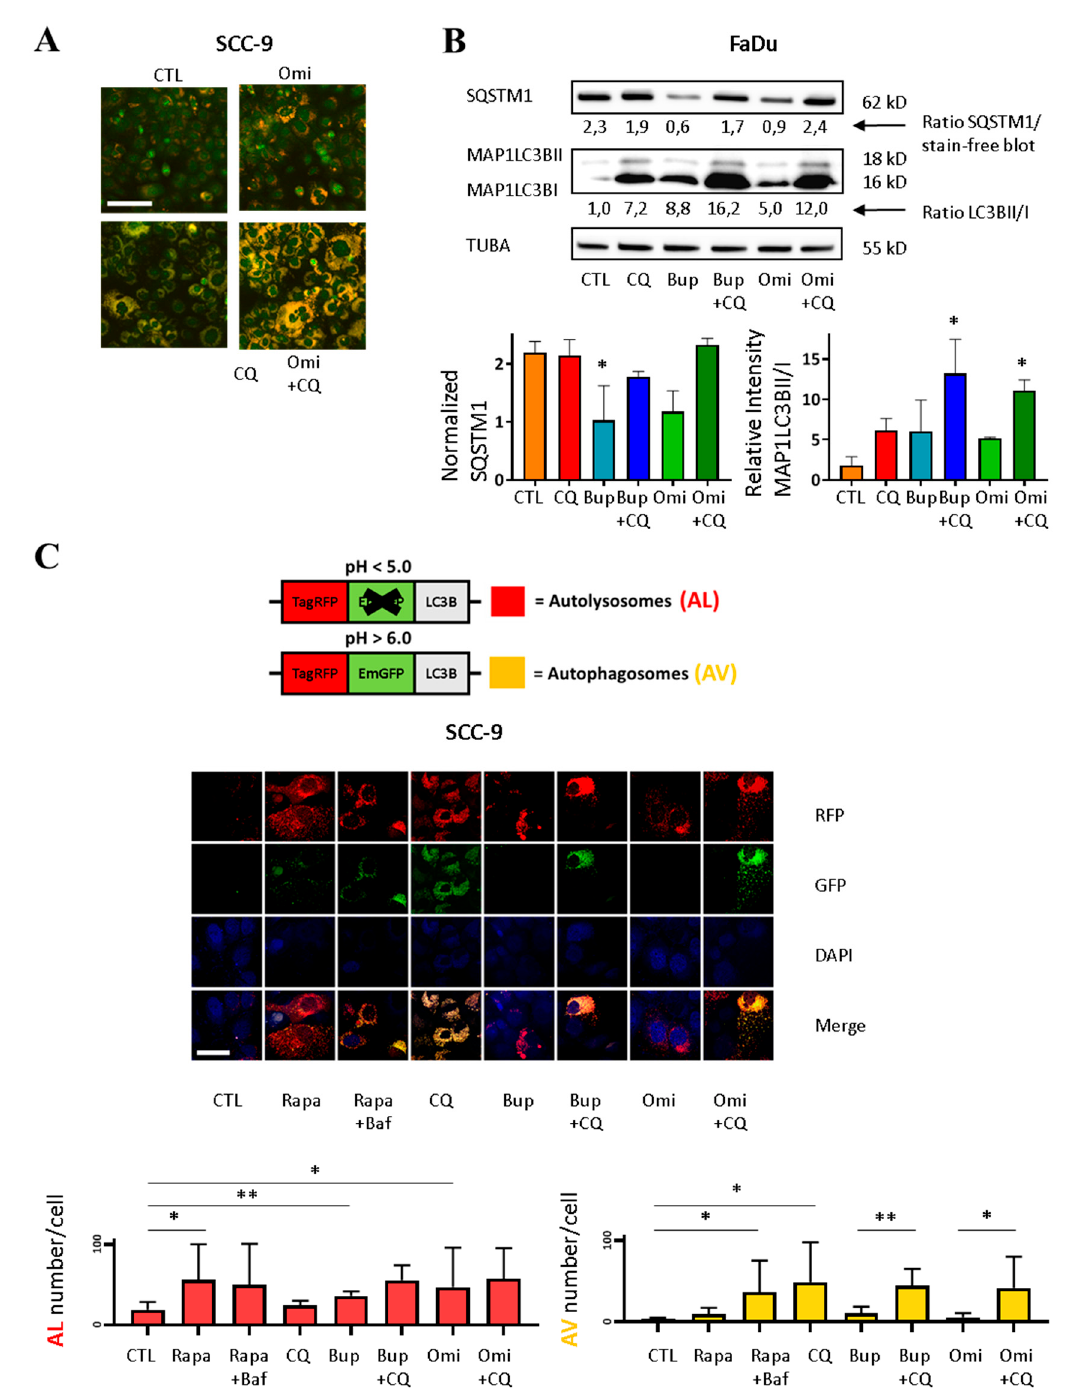
Figure 3. CQ inhibits PI3Ki-induced autophagy in HNSCC cell lines. ( A ) SCC-9 cells were incubated with vehicle DMSO (CTL), 1 nM Omi, 10 µM CQ or both inhibitors for one day and stained for 15 min. with acridine orange. Nuclei stain green and acidic organelles stain orange. Images are representative of three independent experiments. Scale bar = 100 µm. ( B ) Top: Western blot of autophagy markers SQSTM1 and MAP1LC3B, using alpha-tubuline as a loading control. FaDu cells were incubated for 3 days with vehicle, 0.5 µM Bup or 1 nM Omi and ± 10 µM CQ. Bottom: Densitometric analysis of SQSTM1 protein levels relative to TUBA and of MAP1LC3B-II protein levels relative to MAP1LC3B-I. Data are presented as mean ± SD, n = 3 independent experiments and analyzed by ANOVA test. * p < 0.05 for normalized SQSTM1 Bup vs CTL and for relative MAP1LC3B Bup + CQ vs CTL and Omi + CQ vs CTL. ( C ) Autophagy flux analysis with tandem sensor RFP-GFP- LC3B. Top: GFP is sensitive to acidic pH of AL. Red = AL, yellow = AV. Bottom: Confocal images and